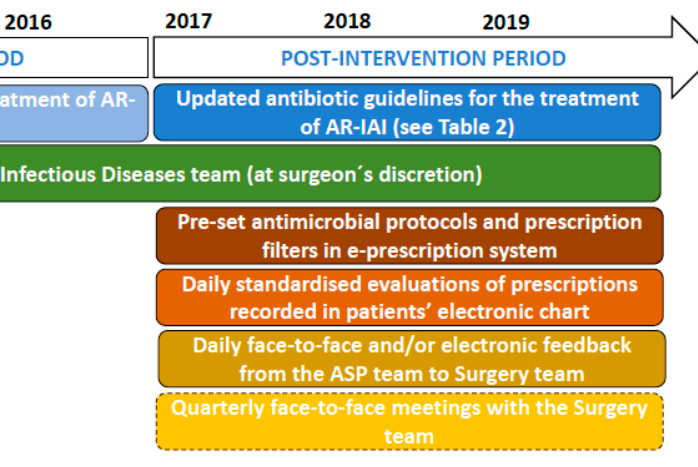
Figure 2. Newly implemented interventions as part of the antimicrobial stewardship program (ASP) to optimise the antibiotic management of children and adolescents admitted due to appendicular-related intraabdominal infections (AR-IAI).